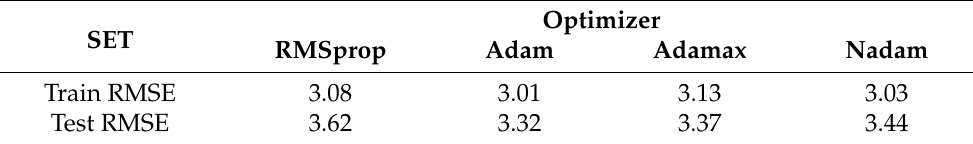
Table 3. Average RMSE for GRU model with attention mechanisms against optimizer variance.